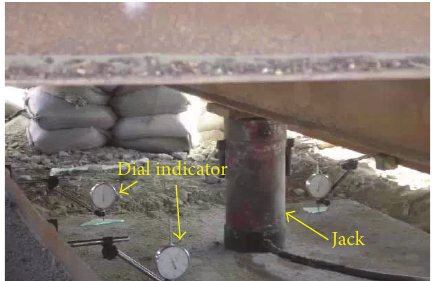
Figure 6: Field diagram of shallow flat plate static load